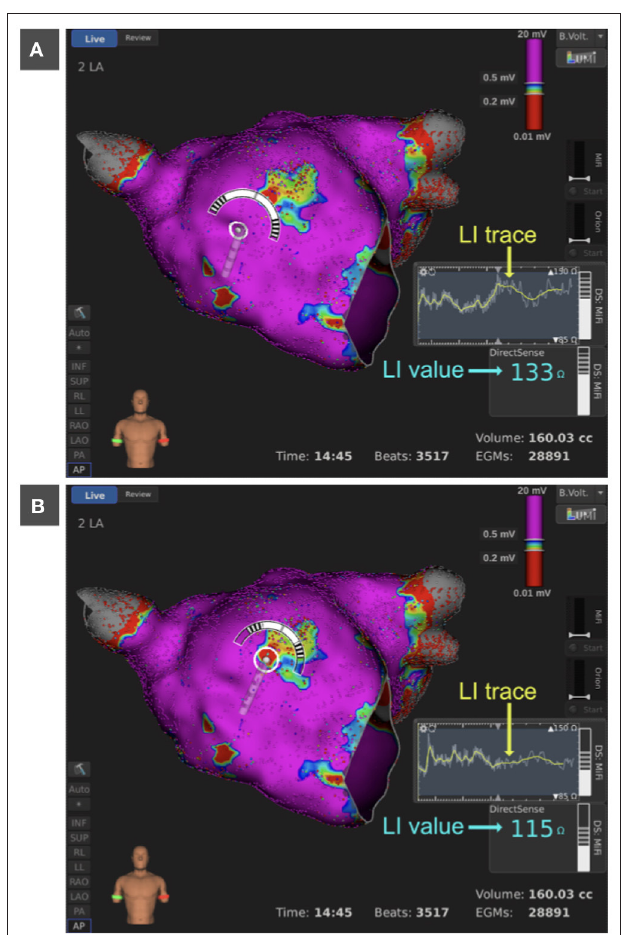
FIGURE 7 | Bipolar voltage map of the LA in anterior view. Bipolar voltages below 0.2mV are colored in red, above 0.5mV in purple and between 0.2 and 0.5mV in rainbow colors. The anterior wall presents centrally with a native pathological substrate of lowered bipolar electrogram amplitude. LI trace presented as an overlap of LI raw (gray) and LI movAvg (yellow) and LI value (light blue) within the pathological region (A) and the adjacent high voltage region (B) . LI, local impedance; LA, left